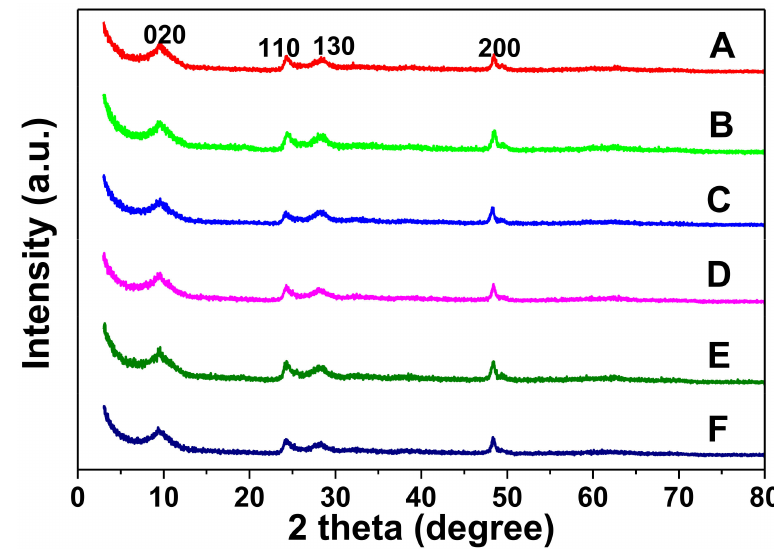
Figure 1. XRD patterns of samples: Rh0.5/TNTs-P ( A ), Rh0.5/Li-TNTs-P5 ( B ), Rh0.5/Li-TNTs-B5 ( C ), Rh0.5/Mg-TNTs-P5 ( D ), Rh0.5/Ca-TNTs-P5 ( E ), and Rh0.5/Sr-TNTs-P5 ( F ).